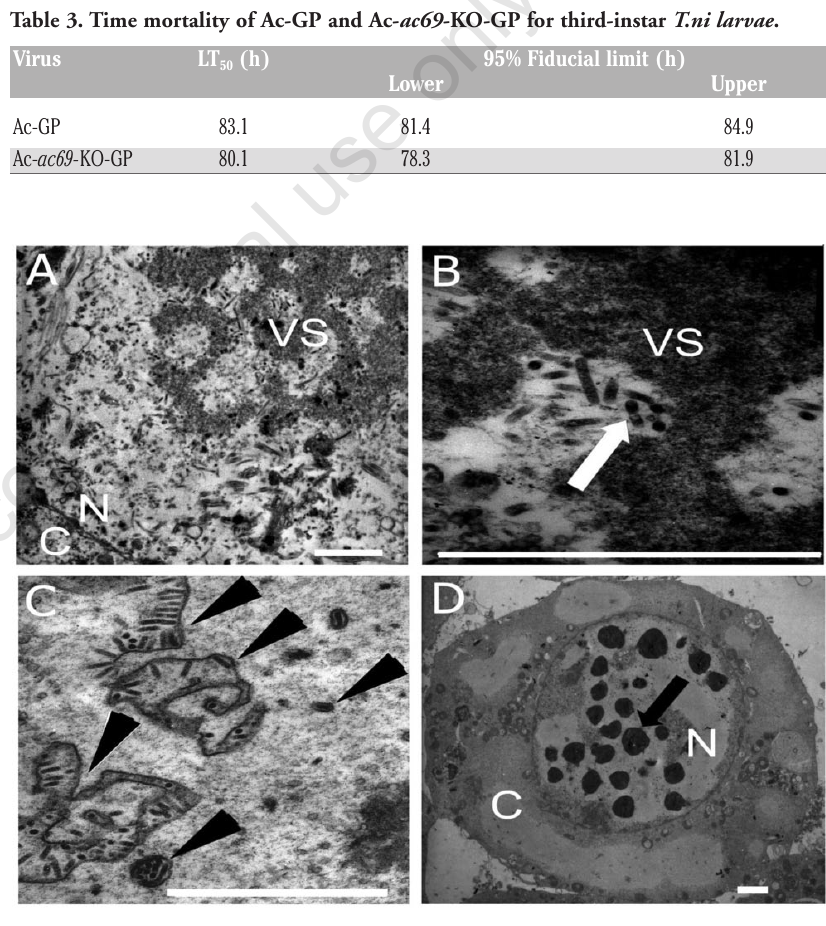
Figure 3. Electron microscopic analysis of Ac- ac69 -KO-GP-infected Sf-9 cells to charac- terize ac69 -null mutant. Panels A and B show virogenic stroma enriched with nucleocap- sids appearing within the nucleus at 24 h p.i. Panels C indicates the aligning of bundles of nucleocapsids with envelopes and their subsequent envelopment to form ODV. Panels D shows occlusion bodies containing ODVs appearing within the nucleus at 72 h p.i. The nucleus (N), cytoplasm (C), and virogenic stroma (VS) regions are indicated. Triangles indicate bundles of nucleocapsids, ODV in the process of becoming enveloped or fully enveloped ODV. White arrow indicates nucleocapsids in the virogenic stroma. Black arrow indicates occlusion bodies containing ODVs within the nucleus. For A, B, C, D the bar represents 1 µm.